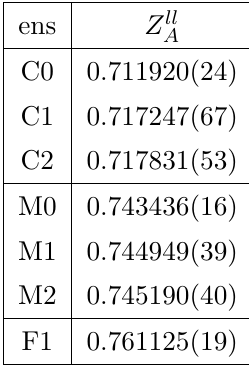
Table 4 . The values for Z A for the various ensembles found from (cid:12)tting a constant to the time dependence shown in (cid:12)gure